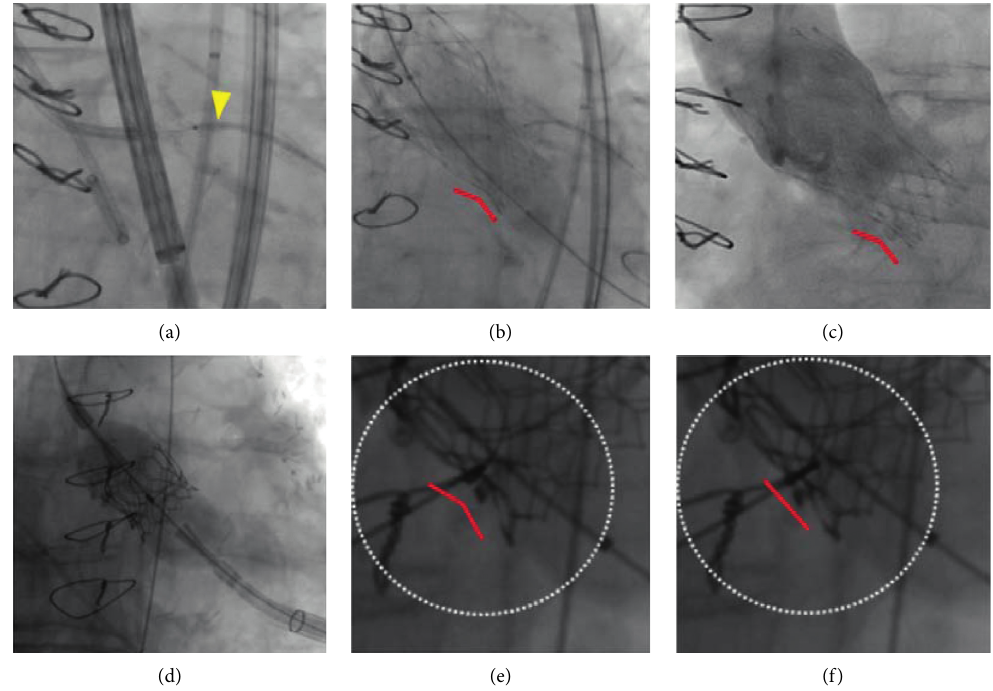
Figure 4: ViV-TAVI with bioprosthetic valve fracture and suboptimal result in a transfemoral (a–c) and good result in a transapical (d–f) approach. (a) In the 91-year-old female patient from Figure 3, because of low coronary height, anticipated bioprosthetic valve fracture, and shallow sinuses, coronary protection was obtained using a 6 F guiding catheter, 6 F GuideLiner, and undeployed stent standby (yellow arrowhead). A 23mm Evolut R valve was implanted 4 mm under the fluoroscopic ring of the Epic valve as a reference. (b) Invasive